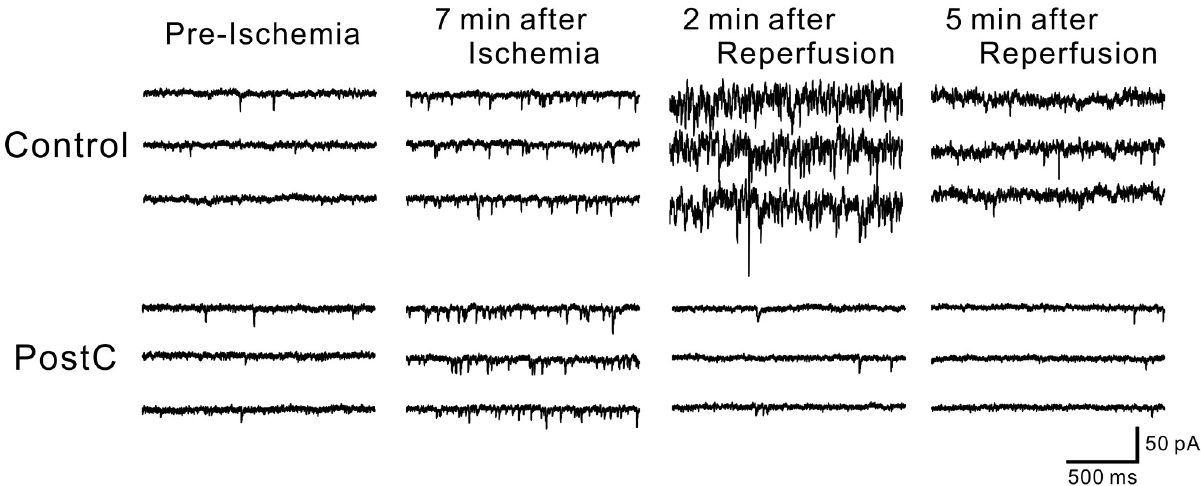
Fig 3. Representative traces of EPSCs for Control (upper) and PostC (lower) groups during pre-ischemic, ischemic and reperfusion periods. In each trace, EPSCs caused by synaptic glutamate releases are observed as transient downward deflections (inward currents). For both Control and PostC groups, the occurrence of EPSCs began to increase apparently 7 min after ischemic perfusion. In the traces of Control group, an explosive increase in EPSC frequency was seen 2 min after reperfusion. On the other hand for PostC group, increased occurrence of EPSCs was receding to pre-ischemic level immediately after